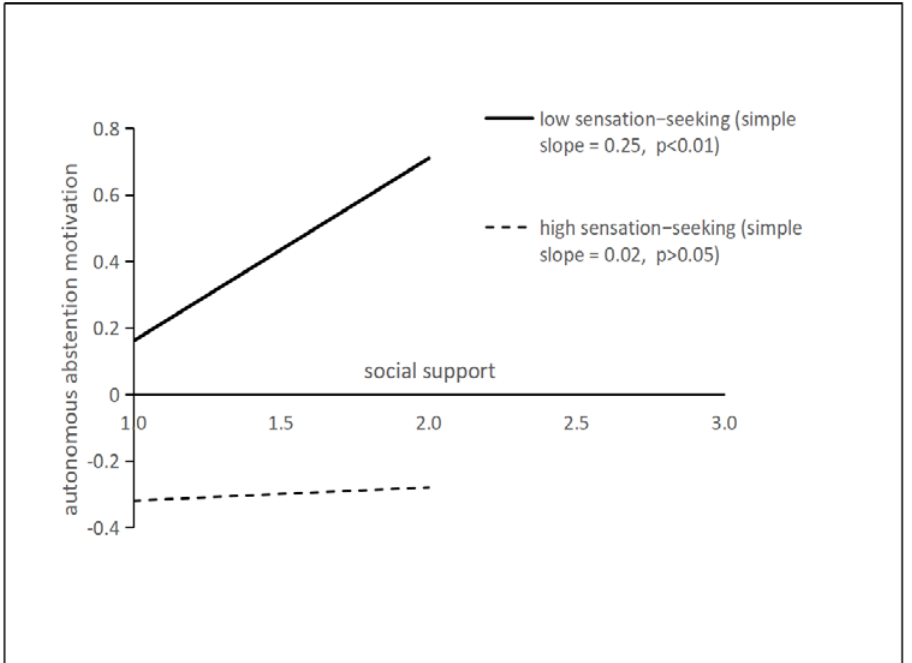
Figure 2. The moderating effect of sensation-seeking on the effect of social support on autonomous abstention motivation.